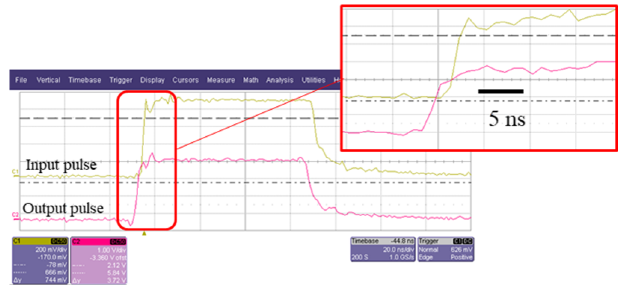
FIG. 3. Experimental results of the temporal response time measurement of apparatus. Yellow trace: input pulse V 0 ; pink trace: output signal V out